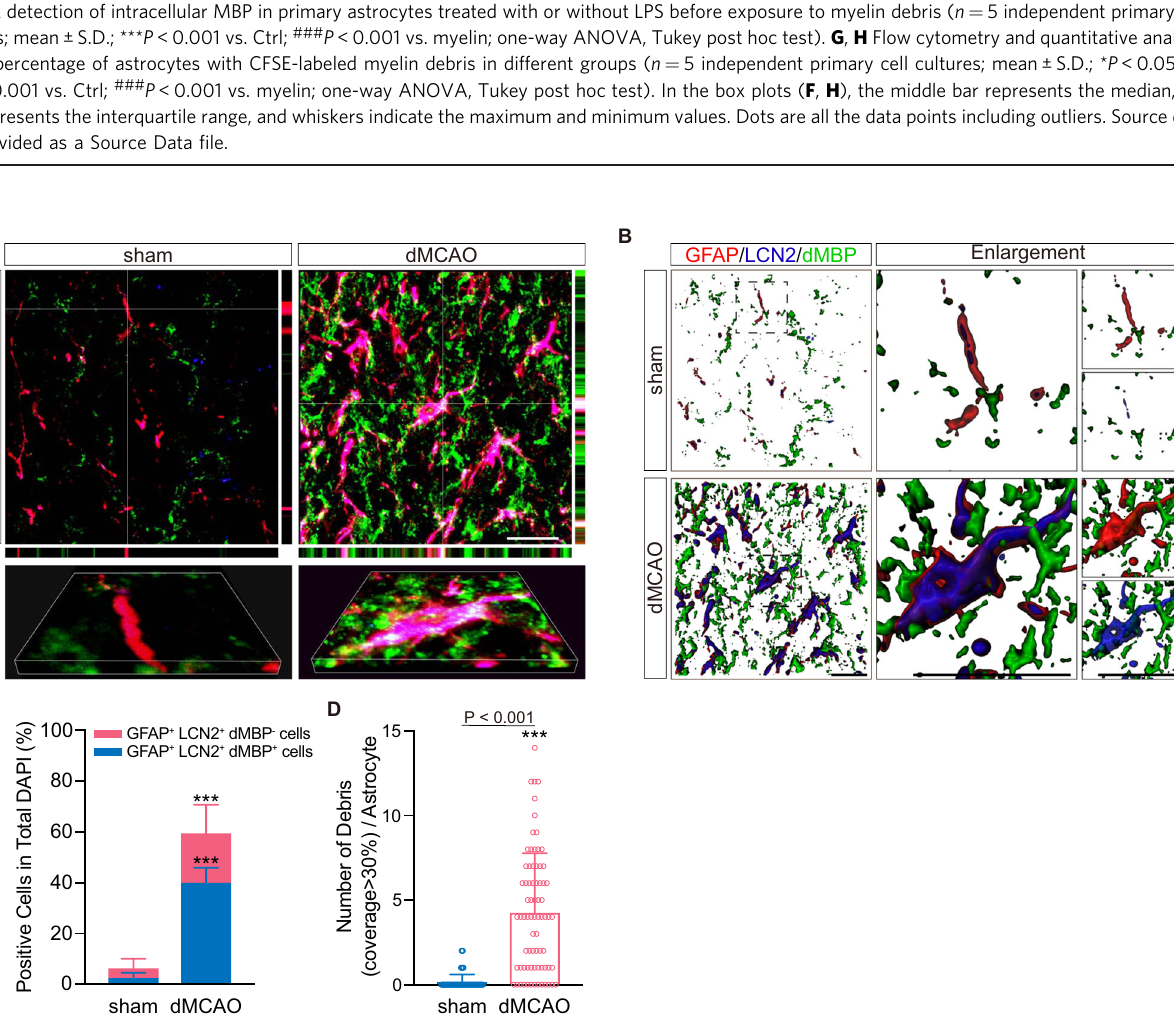
Fig. 2 Engulfment of myelin debris by reactive astrocytes in vivo and in vitro. A Histological analysis of the internalization of myelin debris (MBP, green) by GFAP + (red) astrocytes (white arrows). Myelin debris were located in lysosomes (LAMP1, cyan). Scale bar, 20 μ m. B Representative images of myelin debris (dMBP, green) and lysosomes (LAMP1, cyan) co-positive hypertrophic astrocytes (GFAP + , red; white arrows) in the ipsilateral CC after dMCAO. Scale bar, 20 μ m. C Quantitative analysis for engulfment of myelin debris by hypertrophic astrocytes in sham and dMCAO mice ( n = 5 mice; mean ± S.D.; *** P < 0.001 vs. sham; paired t -test). D Representative EM images of astrocytic phagocytosis in sham and dMCAO groups. Left, the image of an astrocyte in intact CC; Middle, the image of an astrocyte in the ipsilateral CC 7 days after stroke; Right, high-magni fi cation image shown in the middle panel (N nucleus, M mitochondria, in phagocytic inclusion). Red arrows indicated phagocytic inclusions with myelin-like structures. Scale bar, 2 μ m. E Representative images displaying the engulfment of CFSE-labeled myelin debris (green) by LPS-induced astrocytes (GFAP-positive, gray) after exposure to myelin debris, lysosomes (LysoTracker Red dye, red) containing engulfed myelin debris ( n = 5 independent primary cell cultures). Scale bar, 20 μ m. F ELISA detection of intracellular MBP in primary astrocytes treated with or without LPS before exposure to myelin debris ( n = 5 independent primary cell cultures; mean ± S.D.; *** P < 0.001 vs. Ctrl; ### P < 0.001 vs. myelin; one-way ANOVA, Tukey post hoc test). G , H Flow cytometry and quantitative analysis